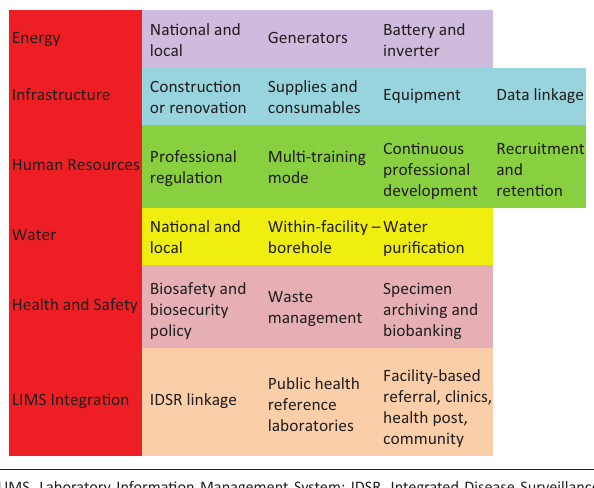
FIGURE 1: Sustainable reconstruction